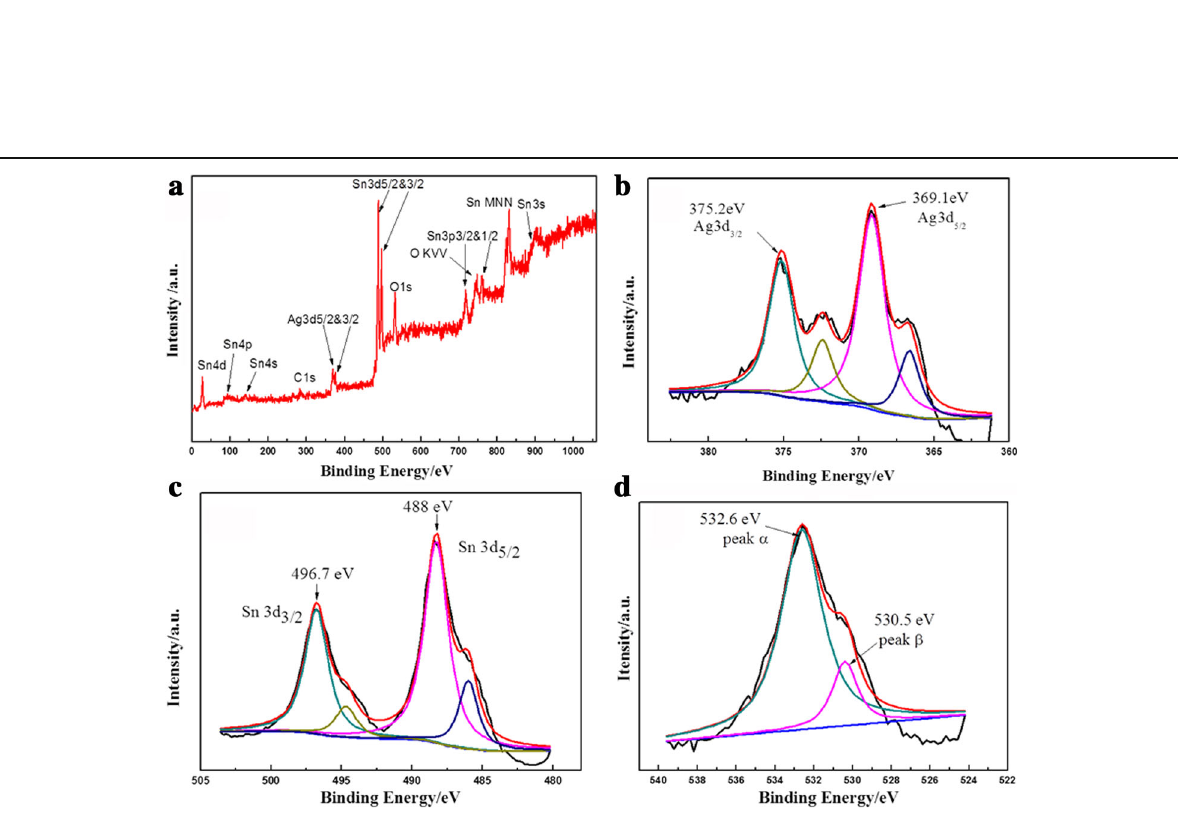
Fig. 5 Representative XPS spectra of SnO 2 /Ag microspheres prepared at 150 °C for 36 h. a XPS full spectra. High-resolution spectra of the elements b Ag, c Sn, and d O